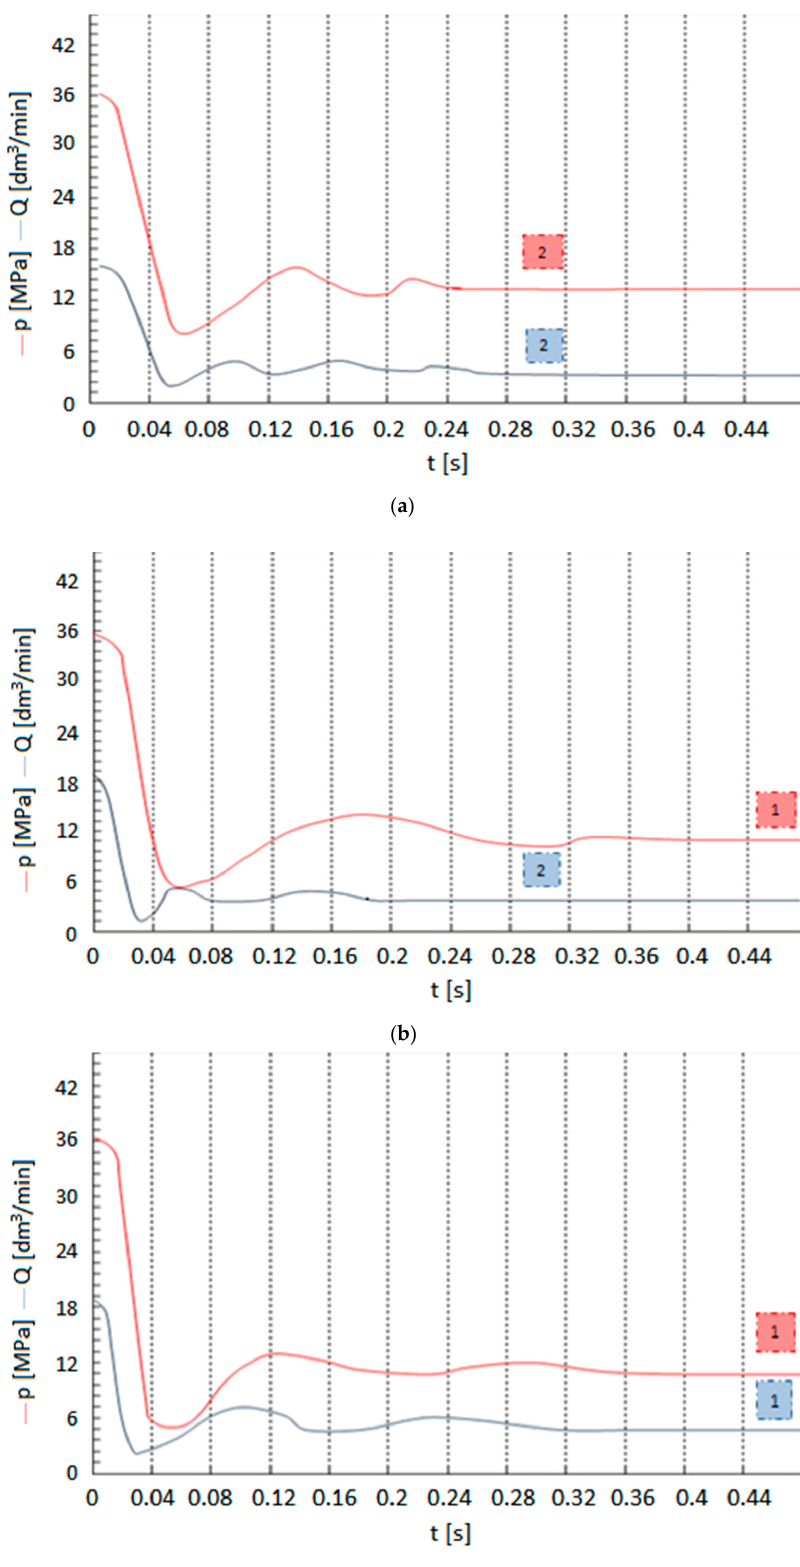
Figure 12. The Q and p time periods for code changes of the K p1 ·K p2 , Q rz , and F m parameters where Q rz : ( a ) 3(023), ( b ) 1(021), and ( c ) 1(220). Runs for a weighting factor value of w i = 3 for ( a ) and w i = 1 for ( b , c ).